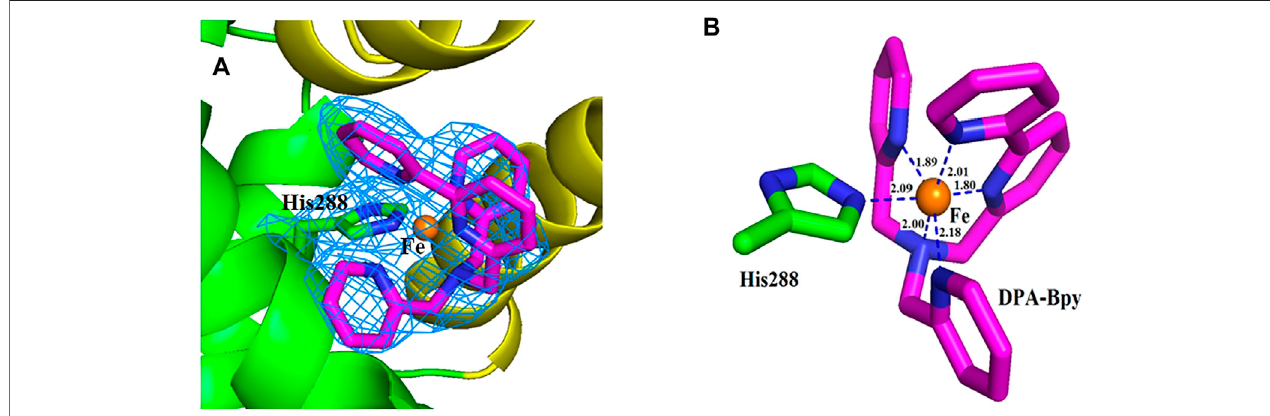
FIGURE6| Closeviewoftheelectrondensitymap(2 Fo − Fc )ofthebindingsitefortheFecomplex.Themapiscontouredat1.0 σ andshownasaskybluemesh (A) . Nearest residue to the Fe complex is shown as green sticks. The ligand molecule isshown as pink sticks and Fe ion is shown asbrown spheres (B) . Distances between the atoms are shown as blue dash lines; respectively.